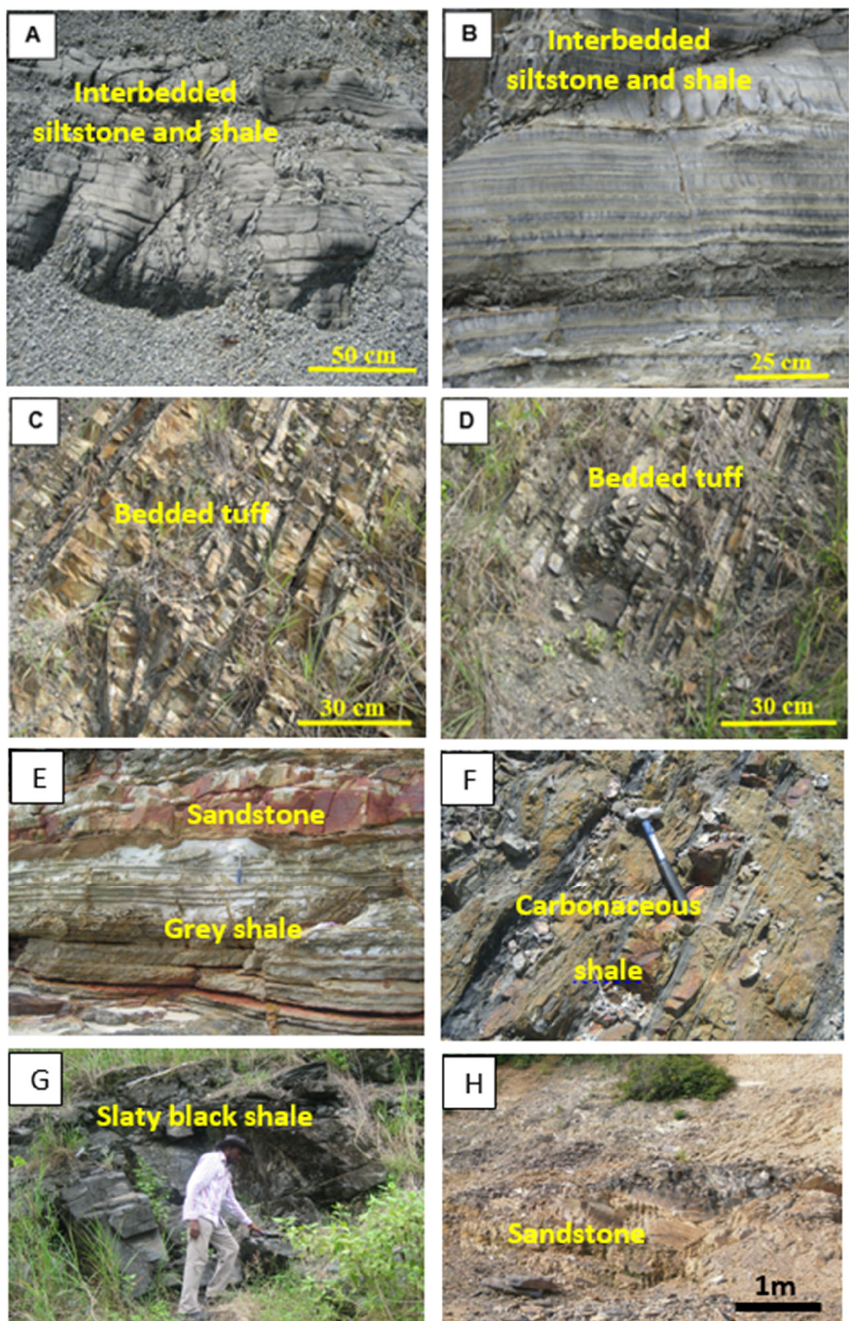
Figure 5. Outcrop photographs of selected formations from where pyrite samples were collected in the field. ( A ) Interbedded black tuffaceous siltstone and black shales from the Semantan sedimentary environment. ( B ) Close-up view of the turbidite sequence. ( C ) Coarse-grained bedded tuff. ( D ) Fine-grained bedded tuff. Field mapping has shown that the Semantan Formation is made up of interbedded tuffaceous siltstone (1–3 cm thick layers) and tuffaceous black shales (up to 2 cm thick layers). The shales contain organic matter laminations (2–3 mm). ( E ) Interbedded sandstone and grey shale of the Machinchang Formation. ( F ) Carbonaceous black shales with siltstone laminations of BRSZ Unit 1. ( G ) Slaty black shale of the Singa Formation. ( H ) The sandstone of the Singa Formation.